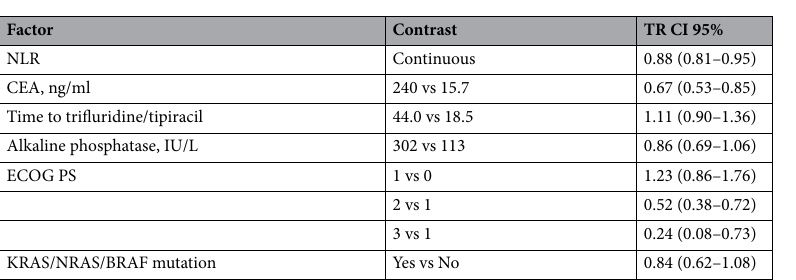
Figure 5. Partial effects of selected variables. Hazard ratio curves allowing non-linear relationships between continuous predictors and overall survival. ( A ) Hazard ratio with non-liner effects for time to TAS-102. ( B ) Hazard ratio with non-liner effects for alkaline phosphatase, IU/L. ( C ) Hazard ratio with non-liner effects for CEA, ng/ml, ( D ) Hazard ratio with non-liner effects for NLR. Abbreviations: NLR, Neutrophil-to-lymphocyte ratio; CEA, Carcinoembryonic Antigen.